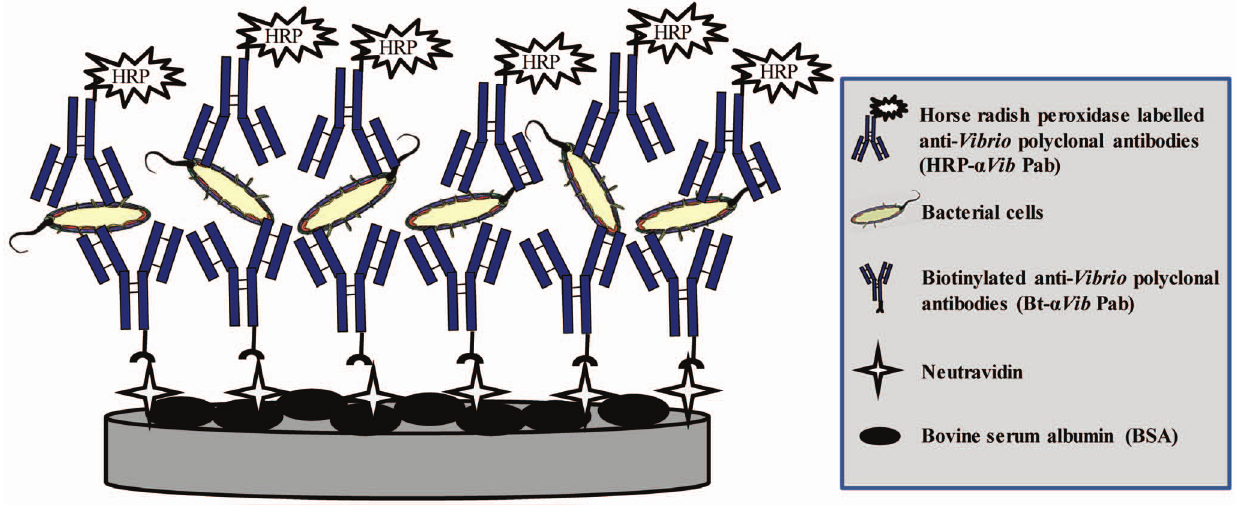
Figure 1. Sandwich-type format carried out in ELISA plate wells for the capture and detection of Vibrio cells. The well surface is coated with neutravidin and blocked with bovine serum albumine. The biotinylated anti- vibrio polyclonal antibody is added and bacterial cells are then captured and detected using an horse radish peroxidase linked anti- vibrio polyclonal antibody that can be detected colorimetrically using a spectrophotometer at 450 nm.